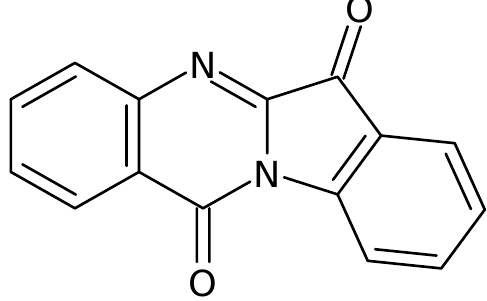
Figure 1. Chemical structure of